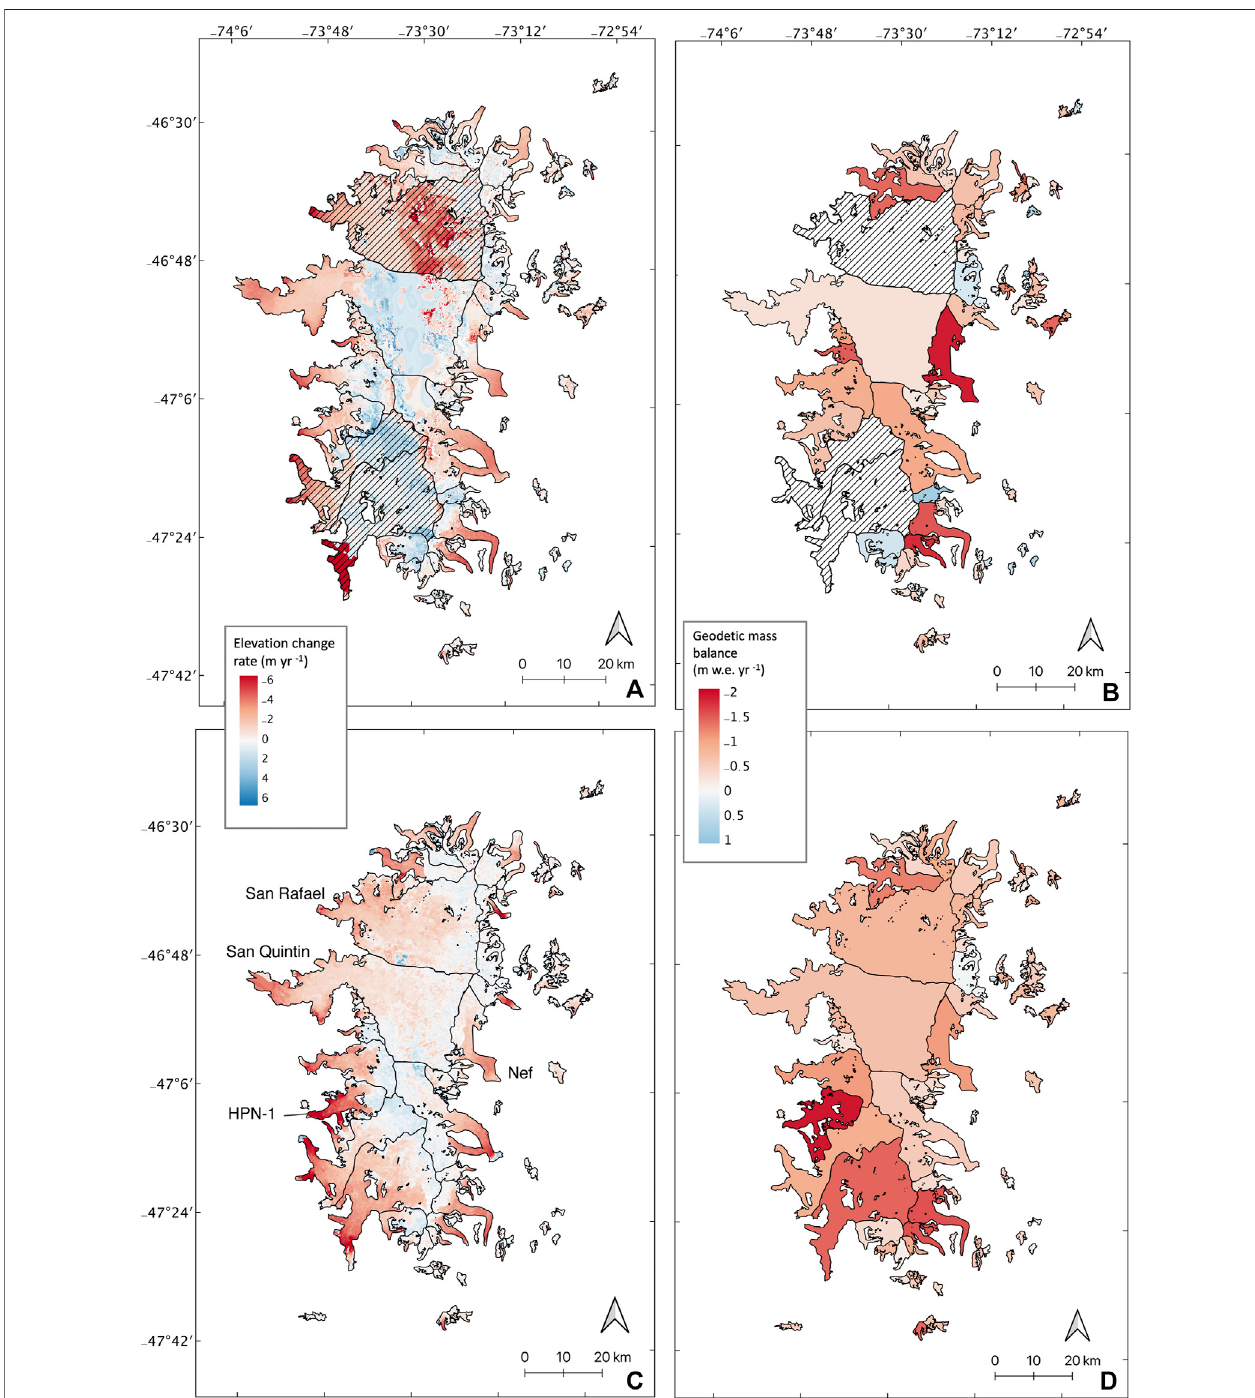
FIGURE 3 | Elevation change observed on the NPI in (A) 1976 – 2000 and (C) 2000 – 2020. Hatched glaciers are those with less than 50% data coverage. This elevation change integrated over the glacier surfaces results in geodetic mass balance for (B) the historical period and (D) the modern period.